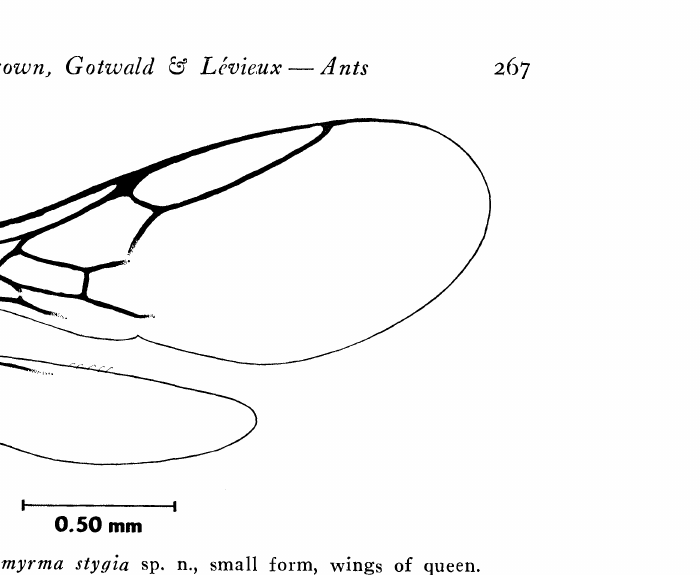
Figure 7, Atomyrma stygia sp. n., small form, wings of queen. femur L 0.30 mm, WL 0.94 mm, petiolar node L o.:4 mm, petiolar node W o.:7 mm, greatest diameter of compound eye o.095